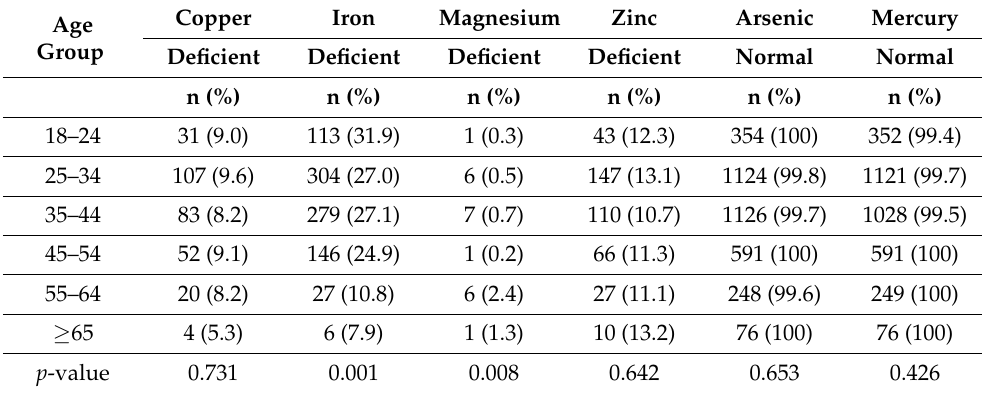
Table A3. Distribution of the Mineral Deficiencies and Heavy Metal Levels Categorized by